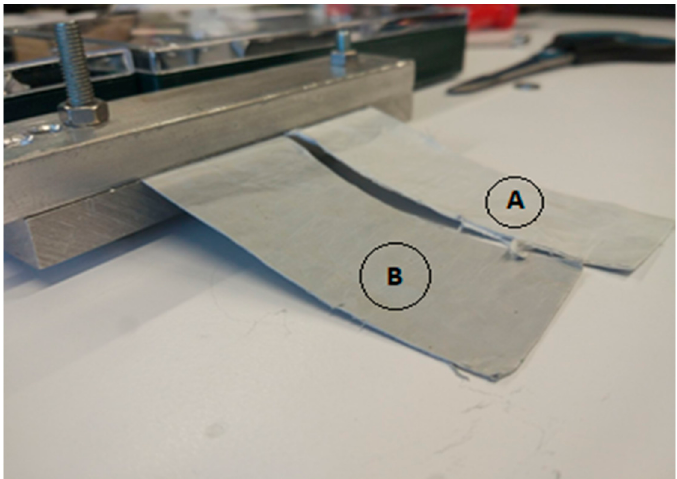
Figure 2. Image of 25% biochar fibers ( A ) and 10% biochar fibers ( B ) clamped on one side before stabilization.